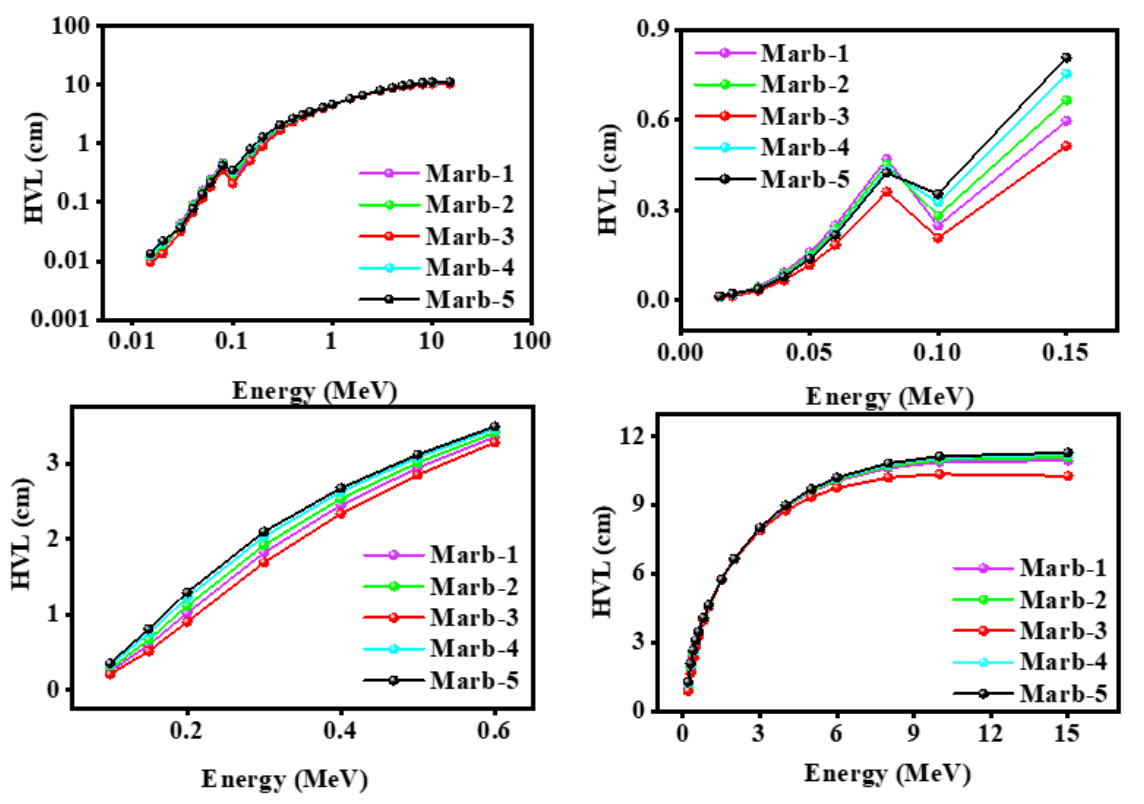
Figure 6. Illustration of the HVL of the prepared composites (polyester/waste marble/PbCO 3 /CdO) against incident photon energy.